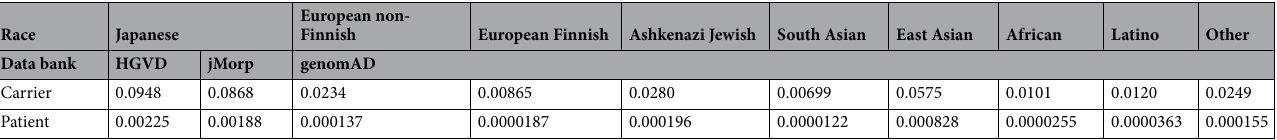
Table 1. Frequencies of carriers of SLC12A3 variants and the prevalence of GS in each ethnicity and database.